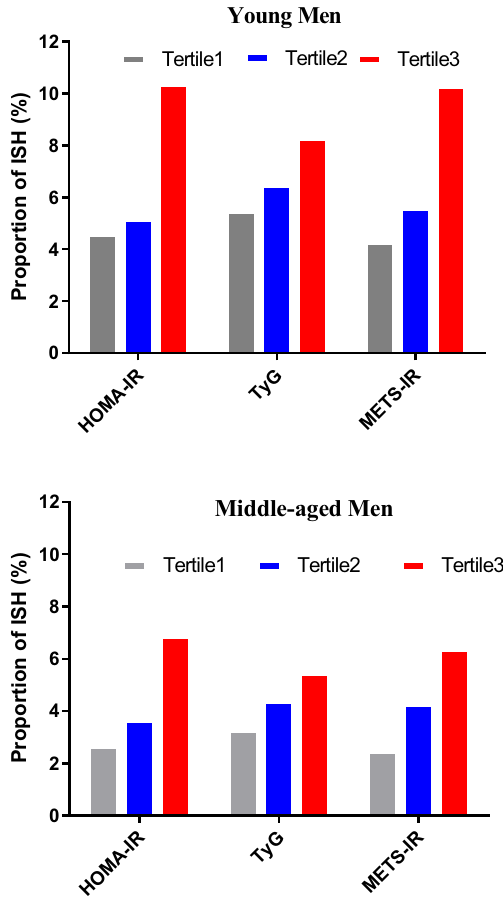
Figure 2. The proportion of ISH by categories of the tertiles of insulin resistance indicators. ISH isolated systolic hypertension, HOMA-IR homeostasis model assessment for IR index, TyG triglyceride glucose index, METS-IR metabolic score for IR, T